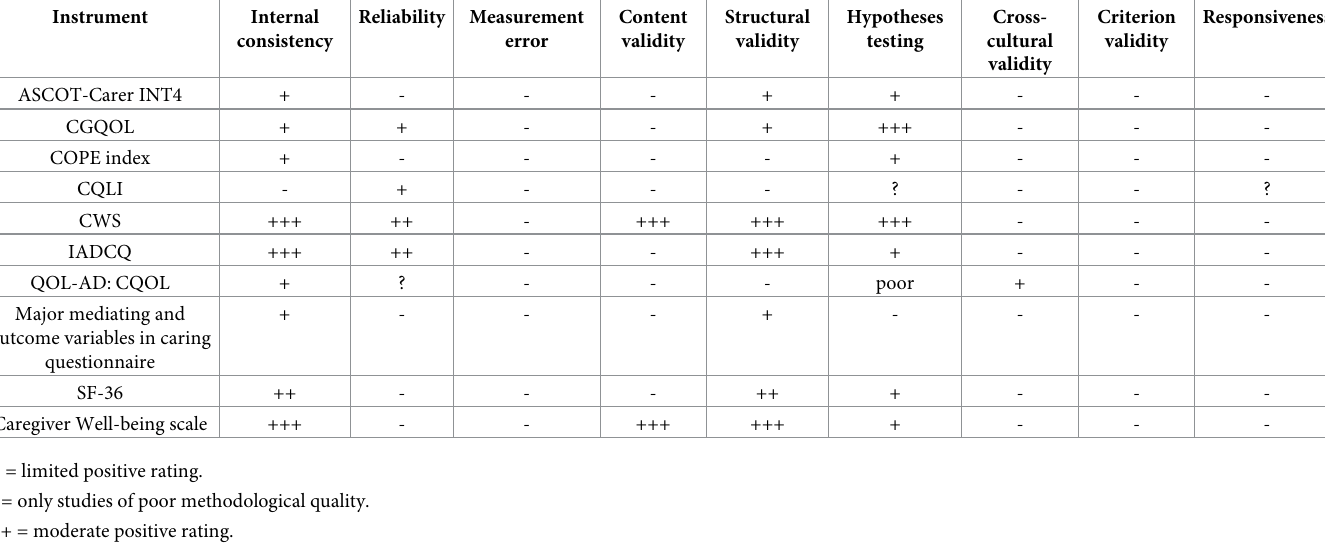
Table 5. "Levels of evidence" for measurement properties of included